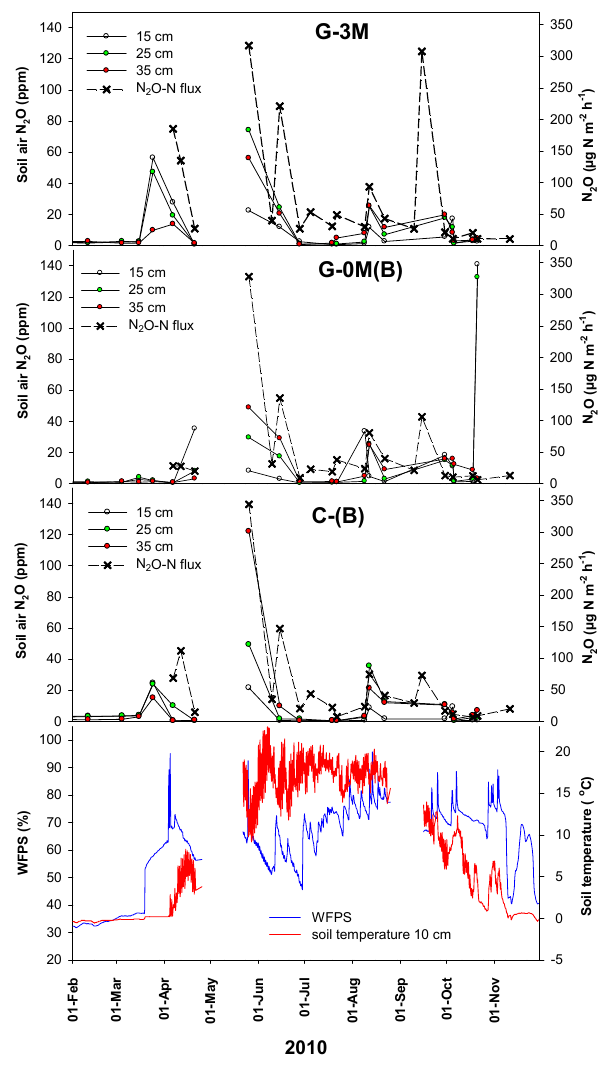
Fig. 3 Fig. 3. N 2 O concentration (ppmv) in soil atmosphere at three dif- ferent depths (left y-axis) and N 2 O emission rates (right y-axis) as affected by different green manure management strategies in 2010. The lowest panel shows the %WFPS (left y-axis) and soil temper- ature (right y-axis) in 10cm depth. Soil air N 2 O concentrations are average values from two replicate sets of soil air probes (3 depths). N 2 O emission rates are the average of four replicates. Soil tempera- ture was calculated as a weighted mean of soil temperature readings in 5 and 20cm